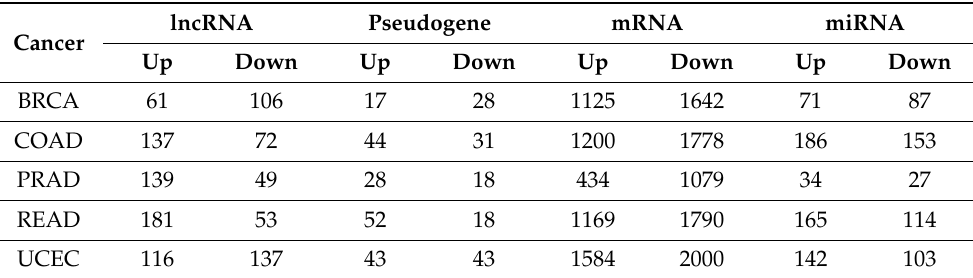
Table 1. Count of differentially expressed (up/down) lncRNAs, pseudogenes, mRNAs, and miRNAs in each hormone-dependent (HD) cancer (corrected for multiple